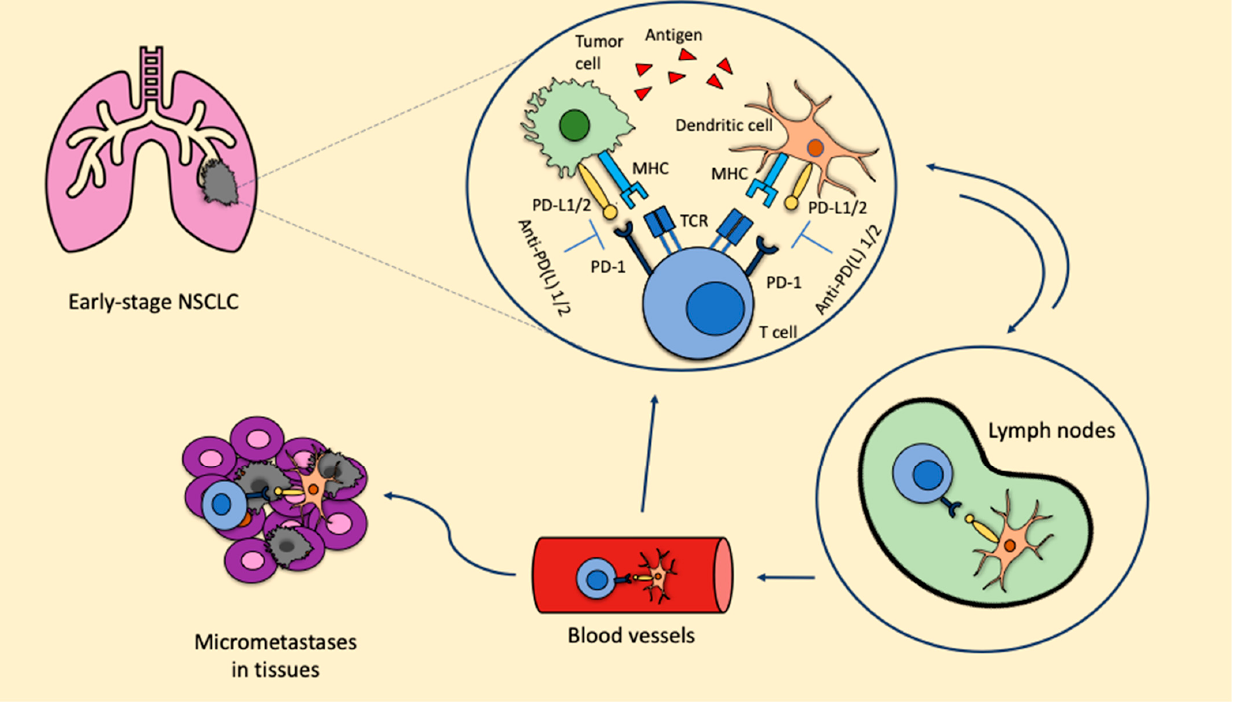
Figure 1. ICIs in the neoadjuvant setting: biological rationale. Anti-PD-L1: anti-programmed cell death-1; MHC: major histocompatibility complex; NSCLC: non-small cell lung cancer; PD-1: programmed cell death protein; PD-L1/2: programmed death ligand 1/2; TCR: T cell receptor.